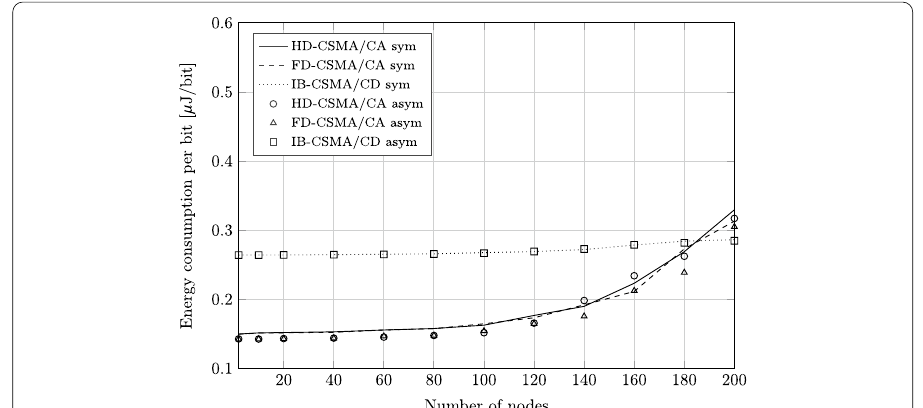
Fig. 12 Unsaturated scenarios (3&4): In unsaturated traffic conditions, the average energy consumption with no interference shows only a minor difference between the three